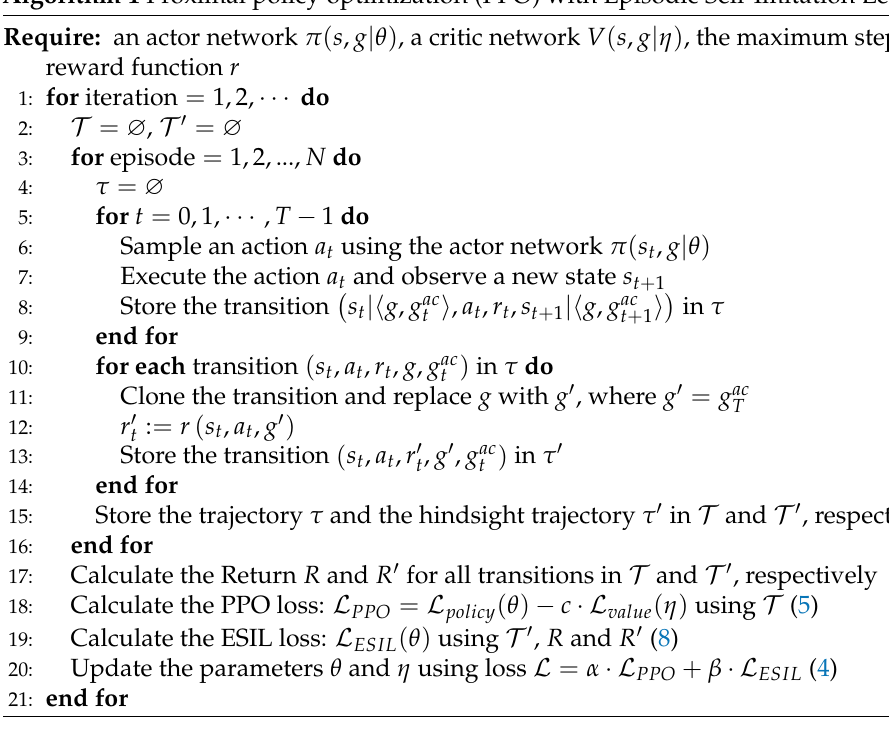
Algorithm 1 Proximal policy optimization (PPO) with Episodic Self-Imitation Learning